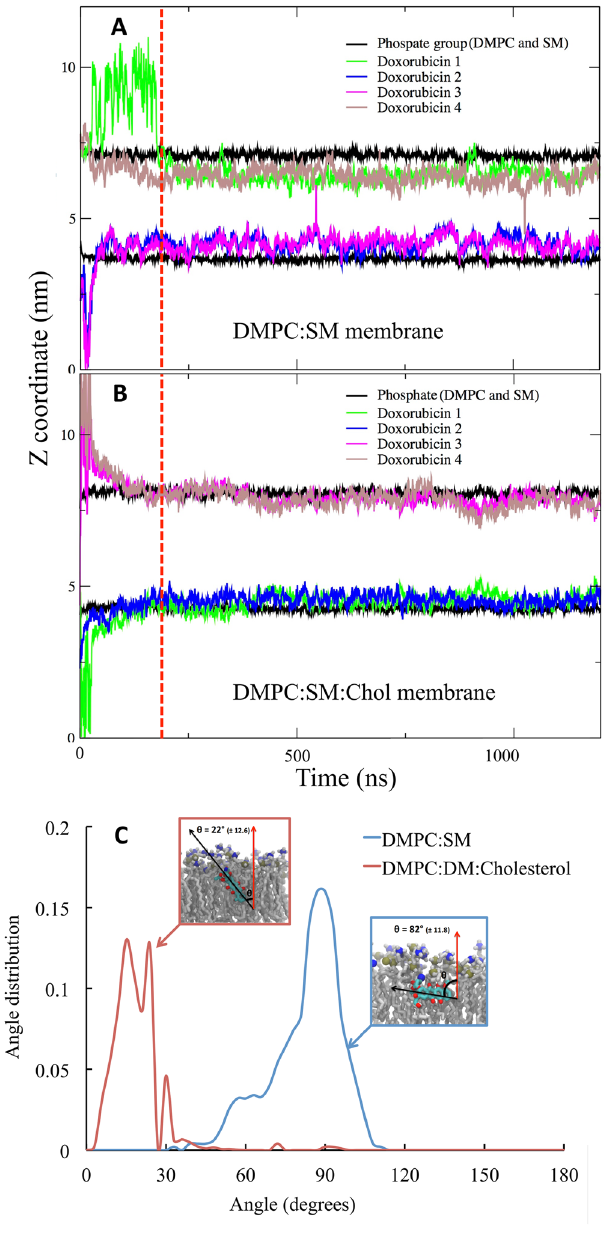
Figure 6. Partitioning of doxorubicin into the membrane bilayer models. The plot shows z-coordinate vs time for the center of mass of the phosphate group (of DMPC and SM) and doxorubicin molecules for ( A ) DMPC:SM [8:2] and ( B ) DMPC:SM:Chol [7:1.5:1.5] membranes. The red dotted line represents time point where systems were considered to be equilibrated, and for all analysis trajectory past this point (200 ns) was used. ( C ) The Angle distribution of doxorubicin in with membrane normal, in DMPC:SM (blue) and DMPC:SM:Chol (red) membranes. The error values represented are calculated as block